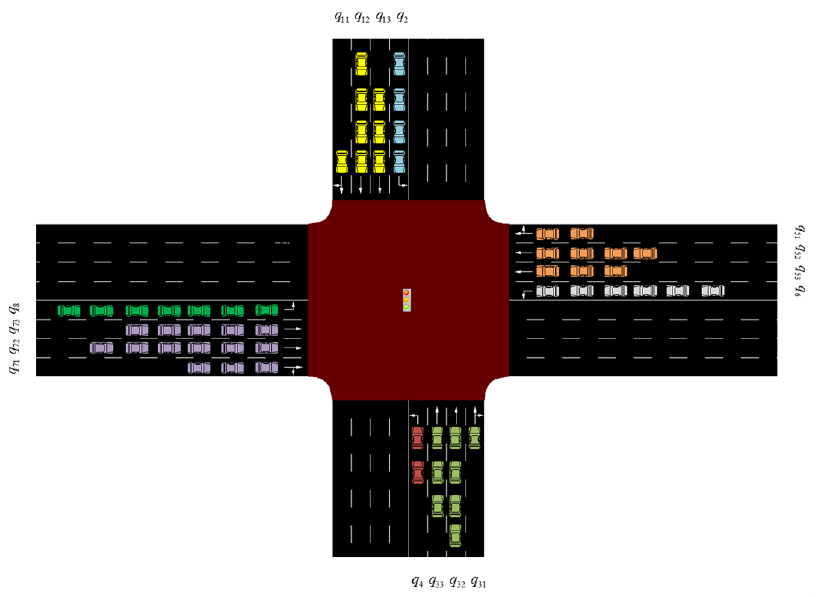
Figure 3. Diagram of the observation